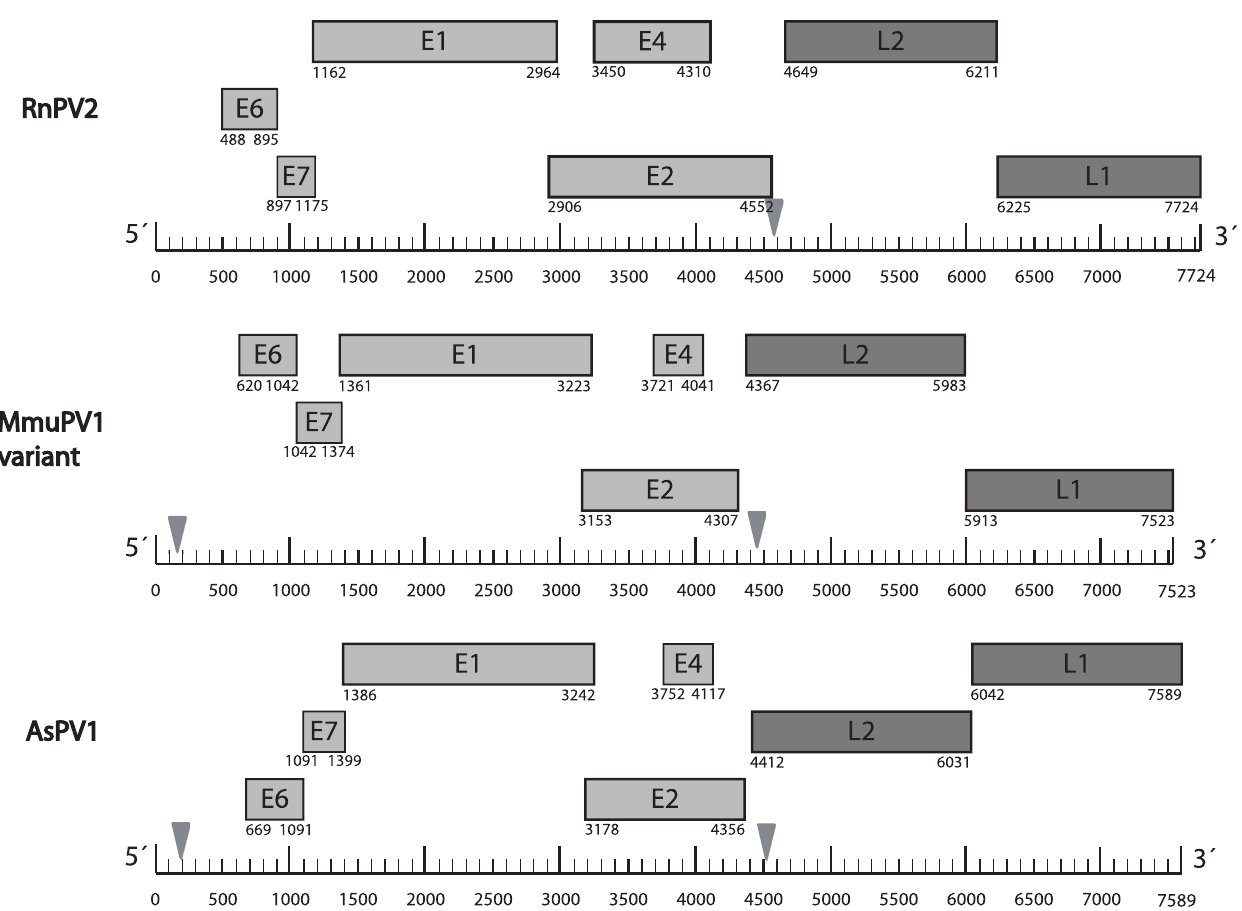
Figure 1. Genome organization of RnPV2, MmuPV1 variant, and AsPV1. Boxes indicating PV genes are drawn to scale and genes are drawn in three lines representing three putative open reading frames relative to nt position zero at the beginning of the upstream regulatory region. The polyadenylation sites are indicated with triangles.